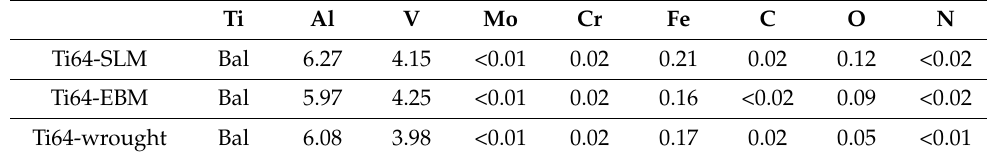
Table 1. Chemical composition of the titanium alloys